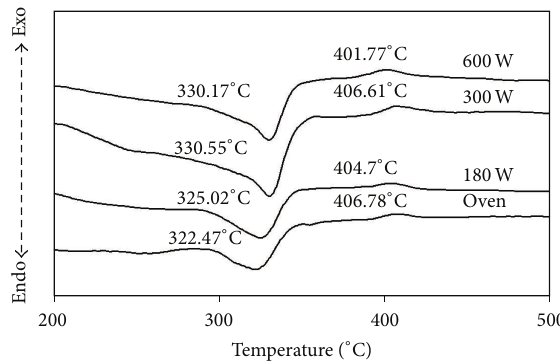
Figure 1: DTA curves of vanadium oxide powders prepared by drying method. A comparison between the oven heating at 100 ∘ C and the microwave heating performed at different irradiation powers of 180W, 300 W, and 600 W.